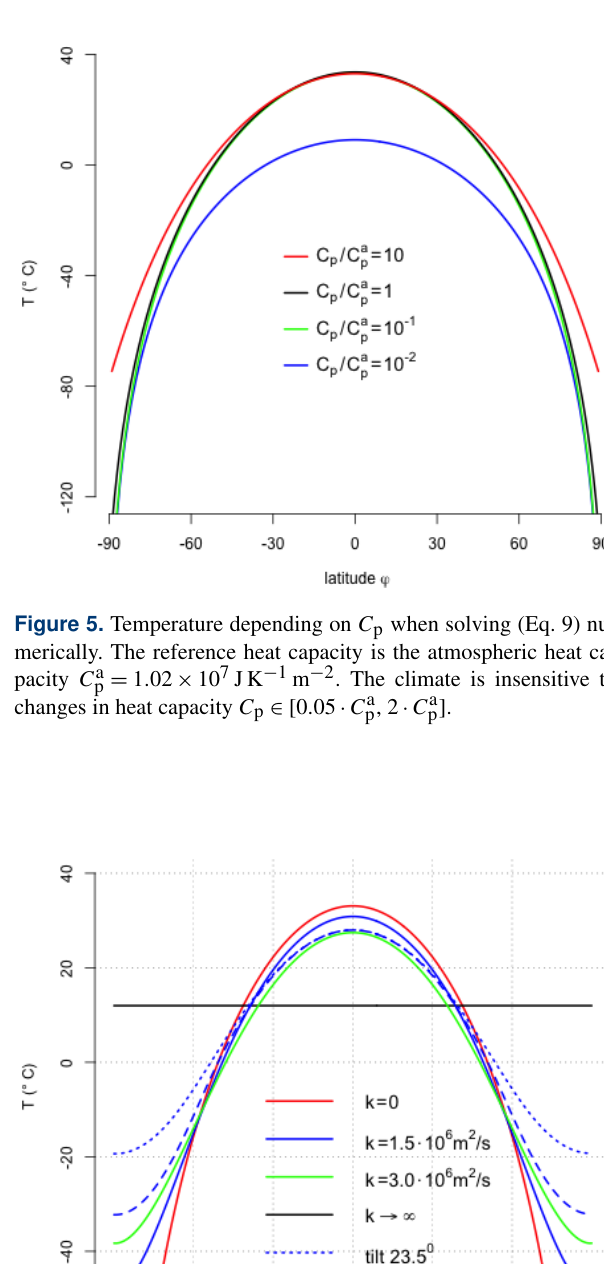
Figure 8. Seasonal amplitude of temperature for the two extreme scenarios in Fig. 7, indicating that the lower seasonality shown by the dashed black line relative to the blue line is linked to a warmer annual mean